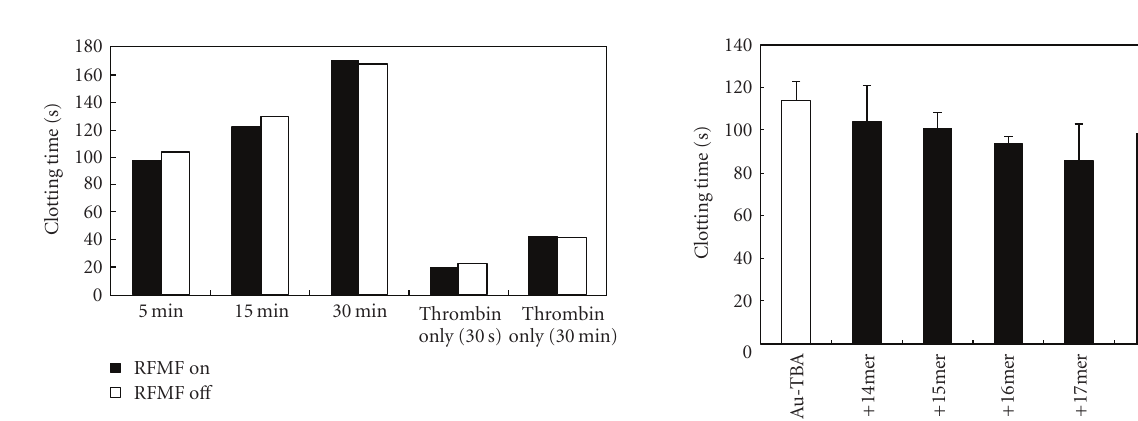
Figure 3: Evaluation of the e ff ect of complementary DNA on TBA inhibitory activity. 14–17-mer, 20-mer, and 23-mer complementary DNA (100 nM) were incubated with Au-TBA (100 nM). The white bar shows the clotting time of thrombin and Au-TBA. The gray bar shows the clotting time of thrombin, Au-TBA, and each complementary DNA strand. Each clotting time represents the average of the clotting times in two experiments, and error bars are